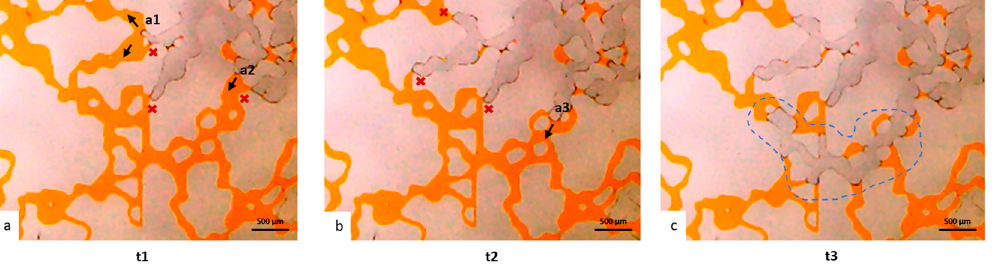
Figure 14. Evolution of the gas front during the drainage process in HO49Y at time t1 ( a ), t2 ( b ) and t3 ( c ). From time t1 to time t3 two seconds elapsed.